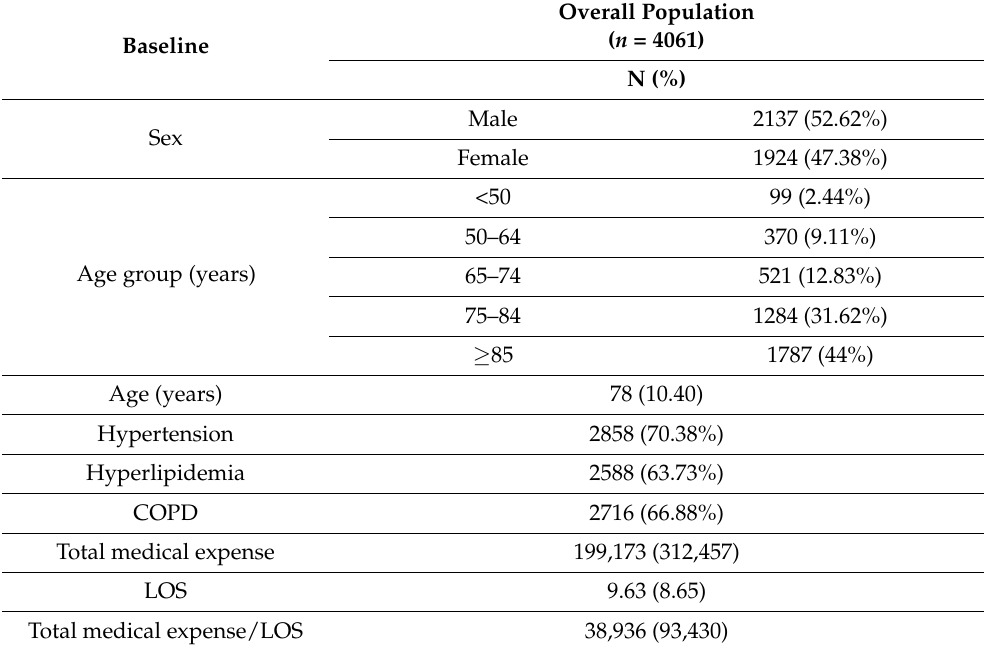
Table 1. Patients’ baseline